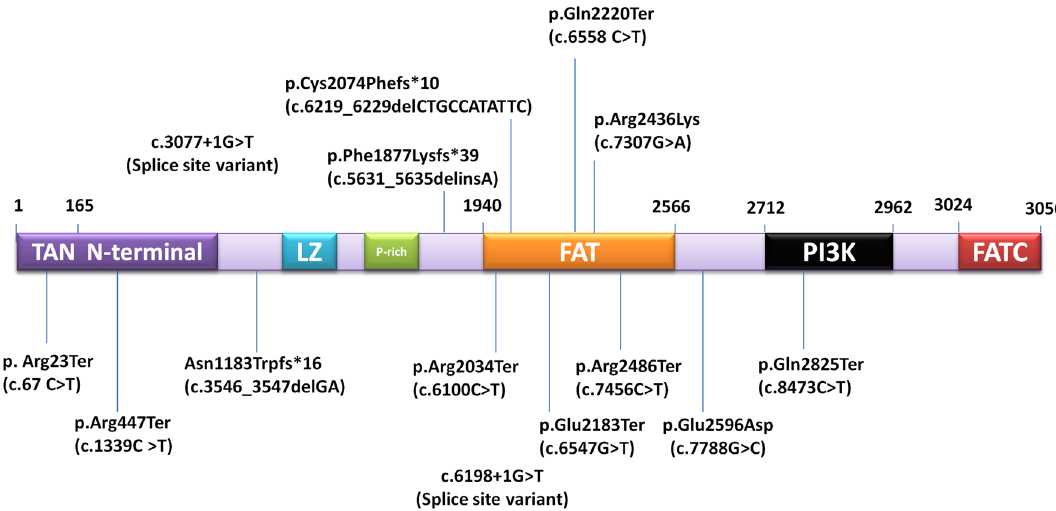
Figure 6. Domain wise depiction of ATM gene variants. LZ leucine zipper motif; phosphatidylinositol 3-kinase (PI3K), FAT FRAP-ATM-TRRAP, FATC FAT